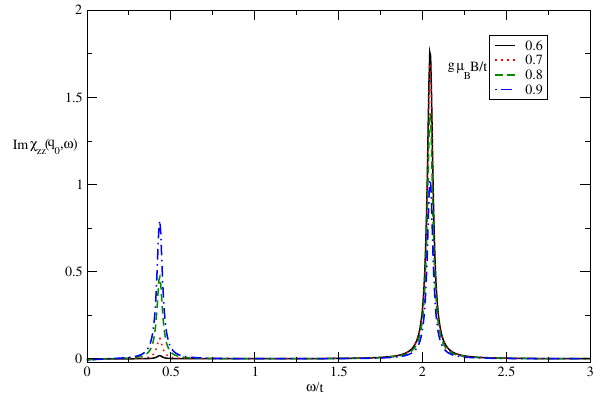
Figure 4. The imaginary part of dynamical longitudinal spin susceptibility Im χ zz ( q 0 , ω) of undoped Germanene layer versus normalized frequency ω/ t for different values of normalized magnetic field g µ B B / t at 0.6 . The normalized temperature is considered to be k fixed spin-orbit coupling (cid:31) / t =